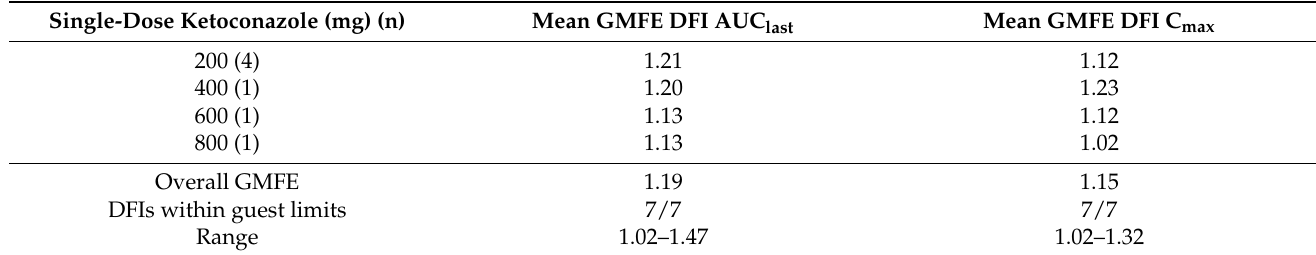
Table 3. Predicted and observed DFI PK ratios alongside quantitative measures of DFI mo- del